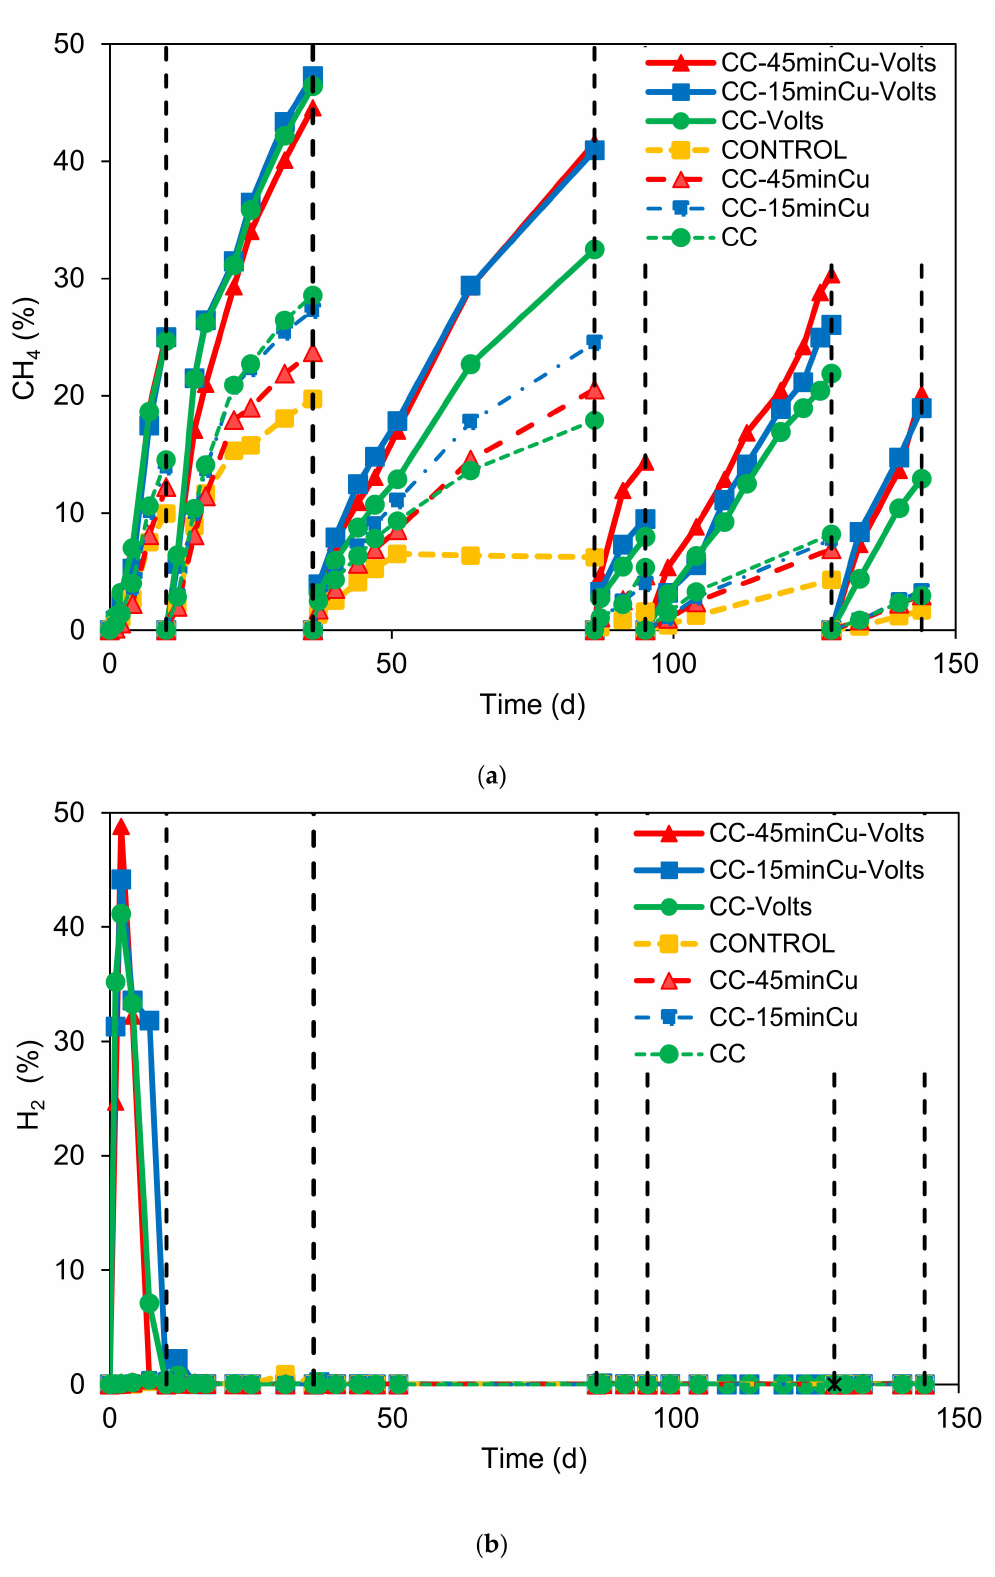
Figure 5. ( a ) Methane composition over time. ( b ) H 2 composition over